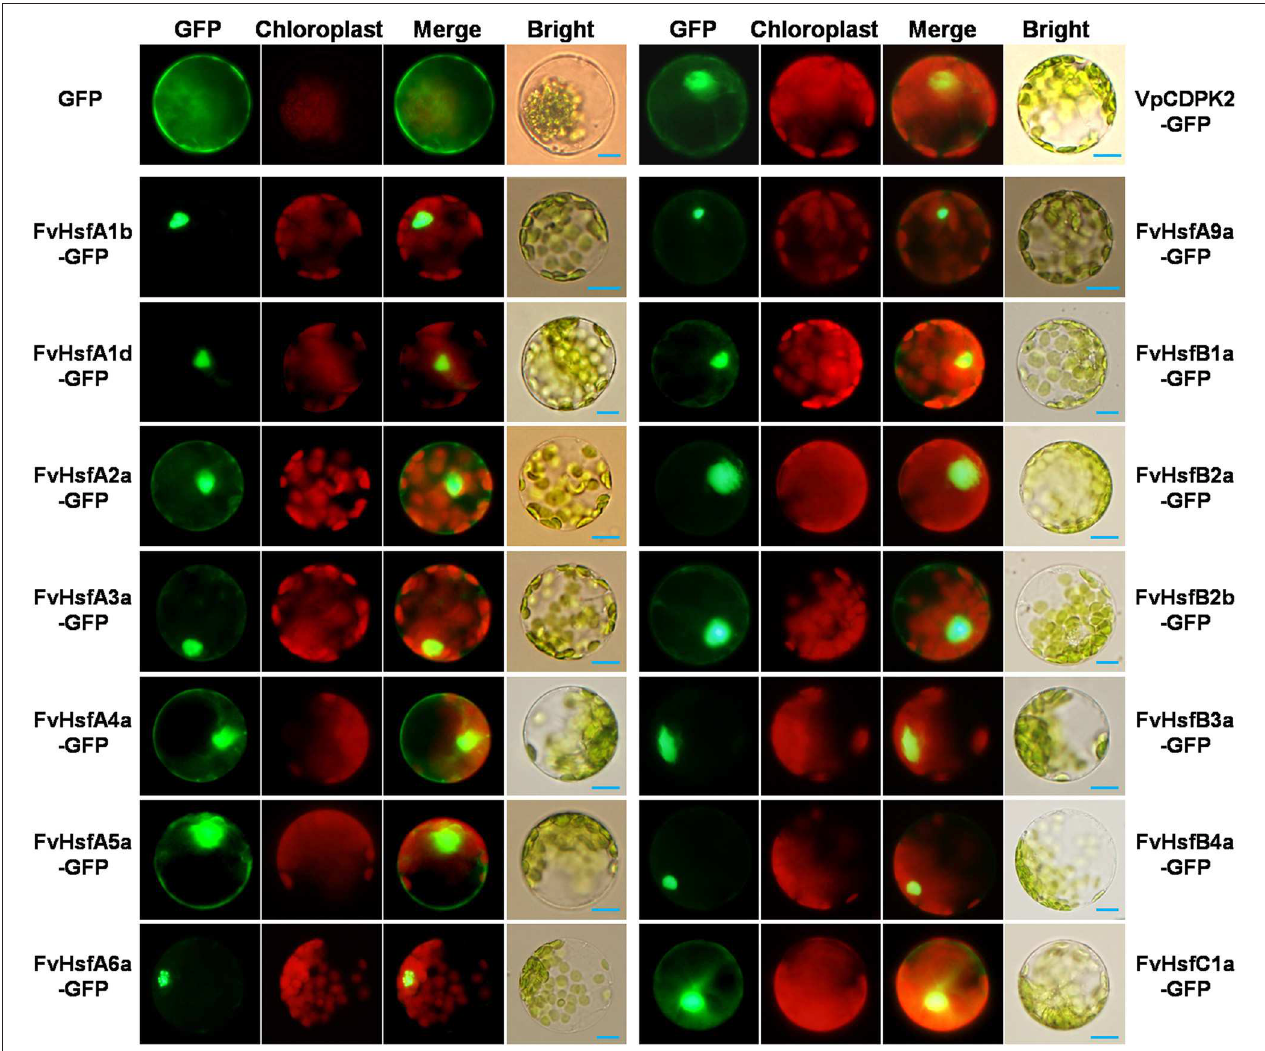
FIGURE 4 | The subcellular localization of 14 FvHsfs. The selected Hsf genes were cloned from a diploid woodland strawberry ( F. vesca ) and used to construct CaMV35S::Hsfs-GFP vectors in which GFP was fused at the C terminus. The 14 FvHsf-GFP fusion proteins (FvHsfA1b-GFP, FvHsfA1d-GFP, FvHsfA2a-GFP, FvHsfA3a-GFP, FvHsfA4a-GFP, FvHsfA5a-GFP, FvHsfA6a-GFP, FvHsfA9a-GFP, FvHsfB1a-GFP, FvHsfB2a-GFP, FvHsfB2b-GFP, FvHsfB3a-GFP, FvHsfB4a-GFP, and FvHsfC1a-GFP), the VpCDPK2-GFP marker protein, and GFP control were transiently expressed in A. thaliana mesophyll protoplasts and observed by fluorescence microscopy. The merged pictures include the green fluorescence channel (first panels) and the chloroplast autofluorescence channel (second panels). The corresponding bright field images are shown on the right. Bars = 10 µ